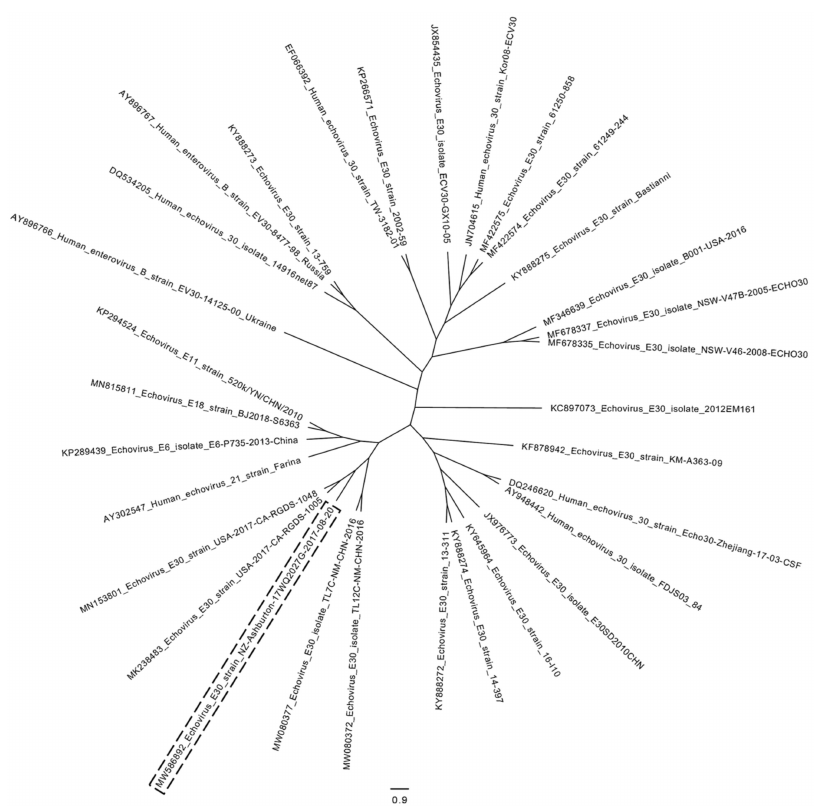
Figure 4. Maximum-likelihood phylogenetic tree (FastTree) of echovirus whole genome sequences after multiple sequence alignment based on fast Fourier transform (MAFFT) visualised with